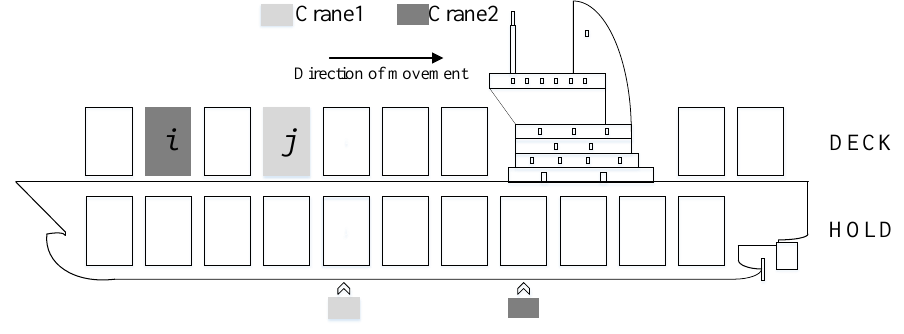
Figure 2. Example of the violation of the branching criterion